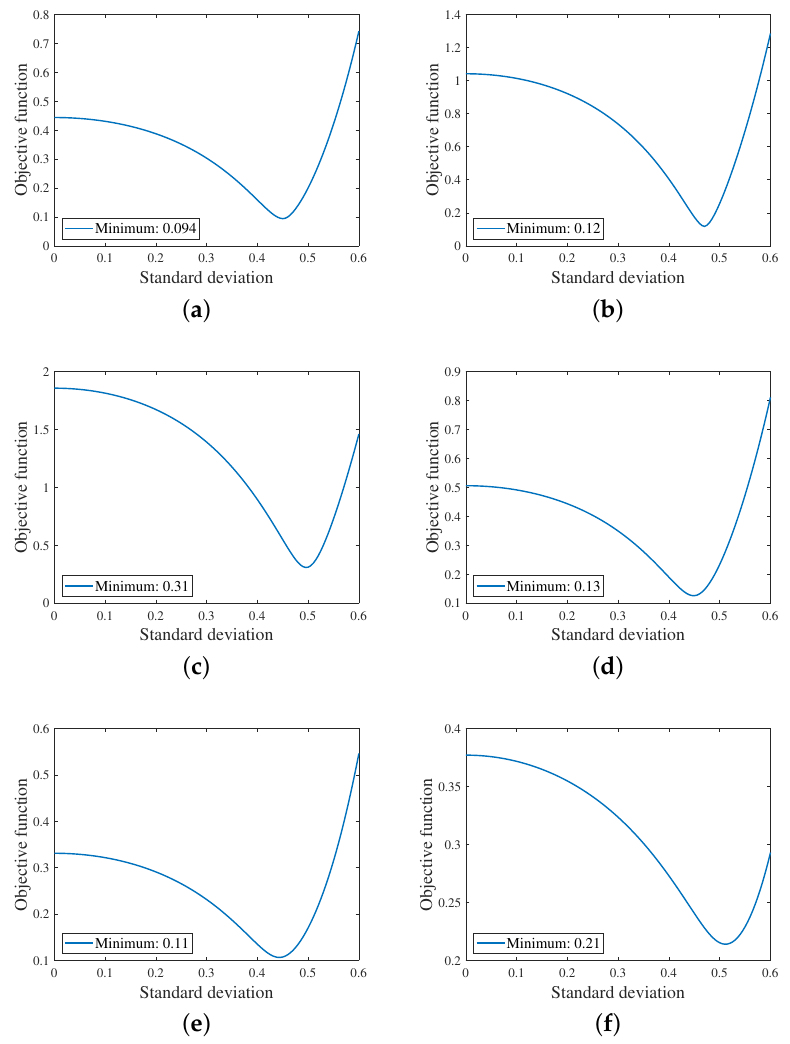
Figure 6. Minimum of the objective function for six inversion processes, ( a ) Sample 1, ( b ) Sample 2, ( c ) Sample 3, ( d ) Sample 4, ( e ) Sample 5, ( f ) Sample